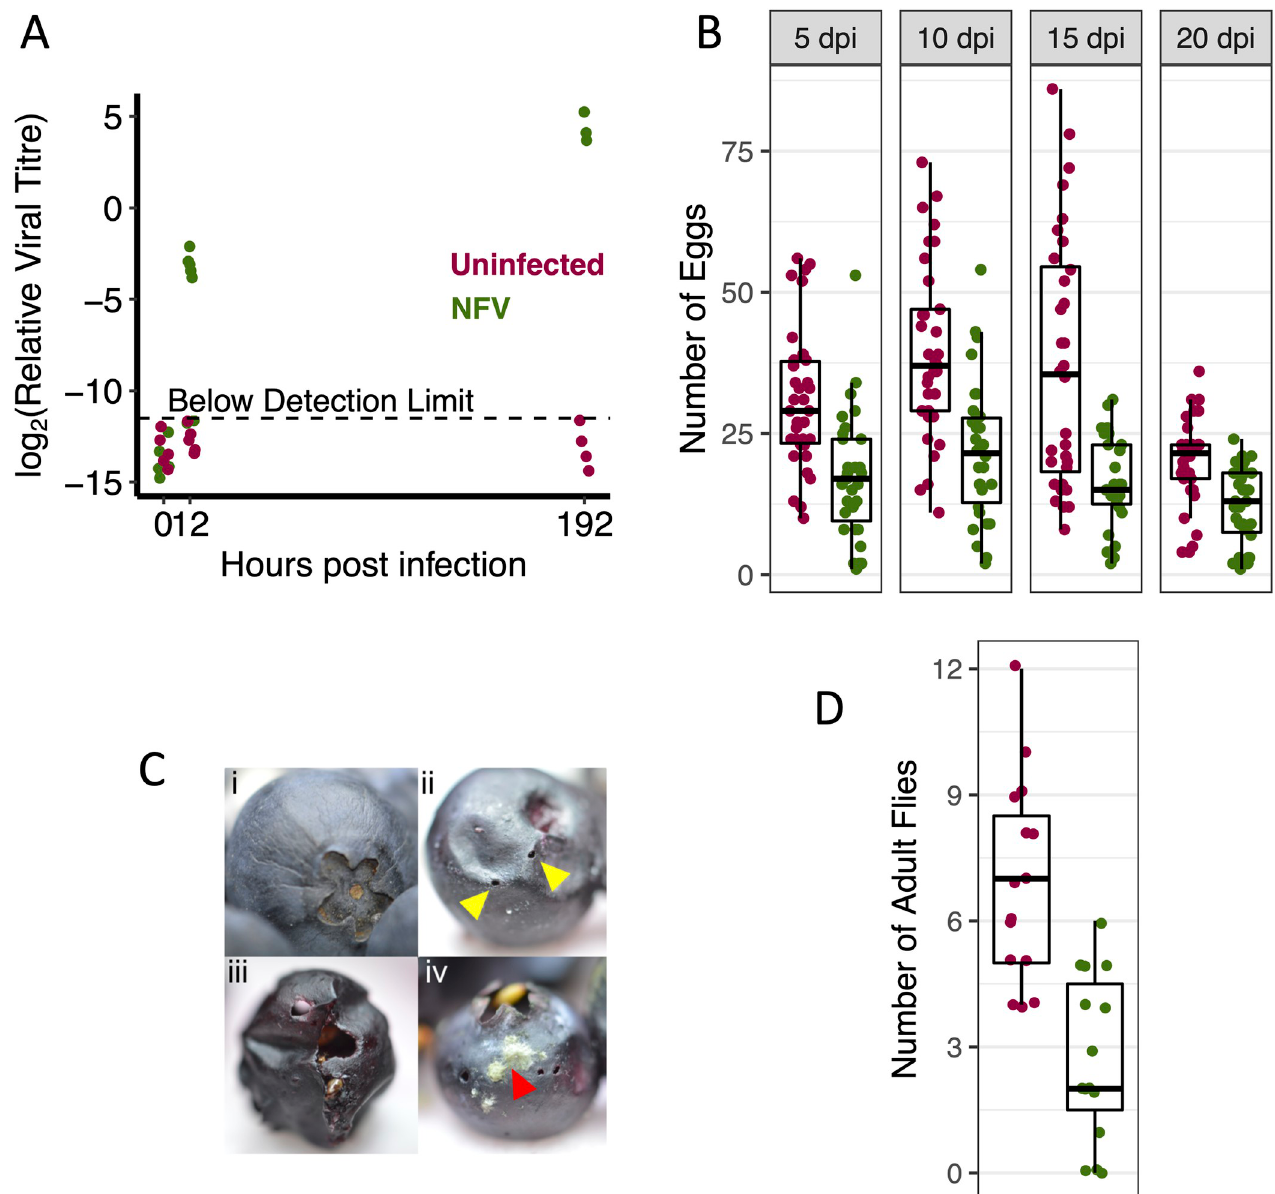
Fig 5. Effect of NFV on the fertility of the crop pest D . suzukii . (A) Viral titre after oral feeding. Each point is a pool of 3–5 flies, and viral RNA levels are measured relative to RpL32 . Samples where NFV did not amplify are shown as below the detection limit and these points are offset vertically. Time zero is immediately after removal from the food containing NFV. (B) Fecundity of D . suzukii orally infected with NFV. Each point is the number of eggs laid by 5 females over 24h. (C) Blueberry fruit (i) before and (ii) after an infestation with D . suzukii , which uses a serrated ovipositor that pierces (yellow triangle) the skin to deposit eggs. The larvae consume the fruit from the inside (iii), and cause the proliferation of opportunistic microorganisms such as fungi (iv, red triangle). (D) The number of adult flies that hatch from blueberry fruits after being infected orally with NFV or fed a control solution. Each point is the number of flies that emerge from two